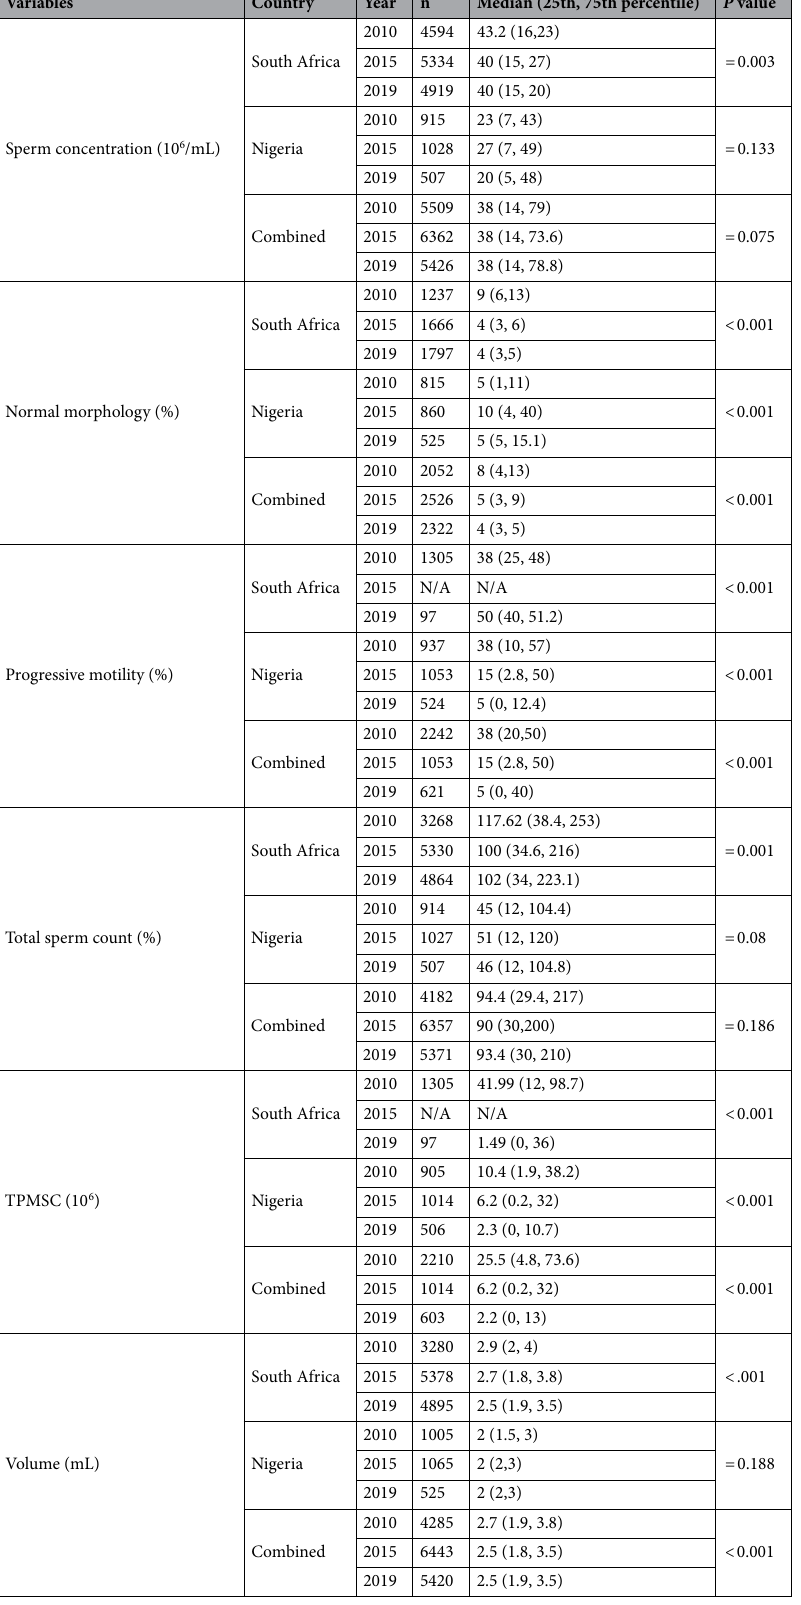
Table 2. Comparison of the independent variables from Nigeria and South Africa and the combination of both